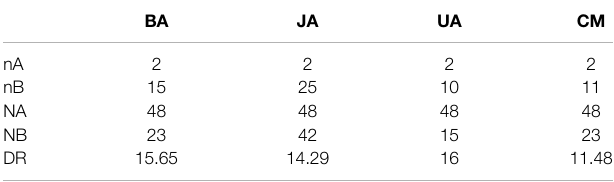
TABLE 2 | Dissociation rate of the PMP in each treated